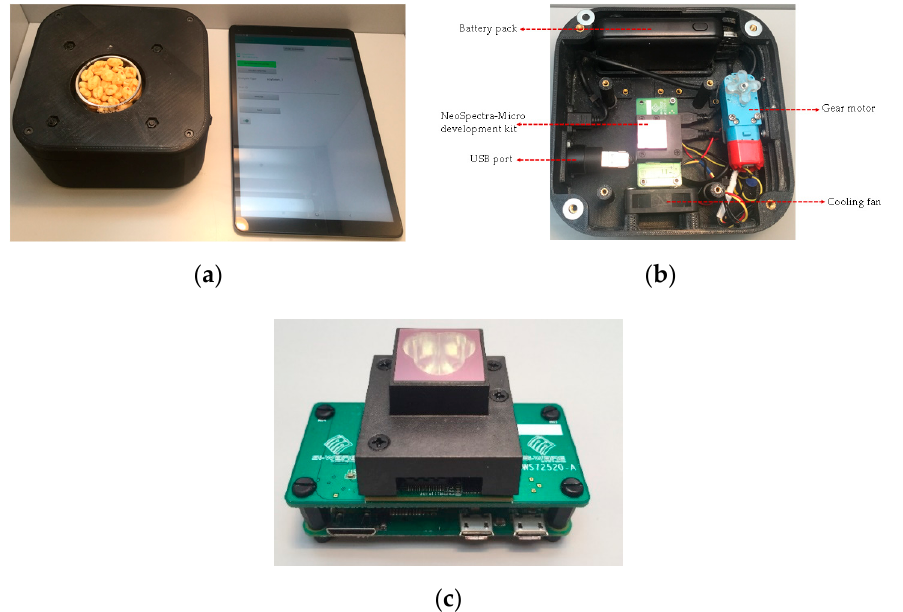
Figure 1. The novel handheld Fourier Transform near-infrared (FT-NIR) spectral sensor prototype used to analyze breakfast cereal samples ( a ), the inner section of the handheld FT-NIR spectral sensor prototype ( b ), and the NeoSpectra-Micro development kit ( c ).